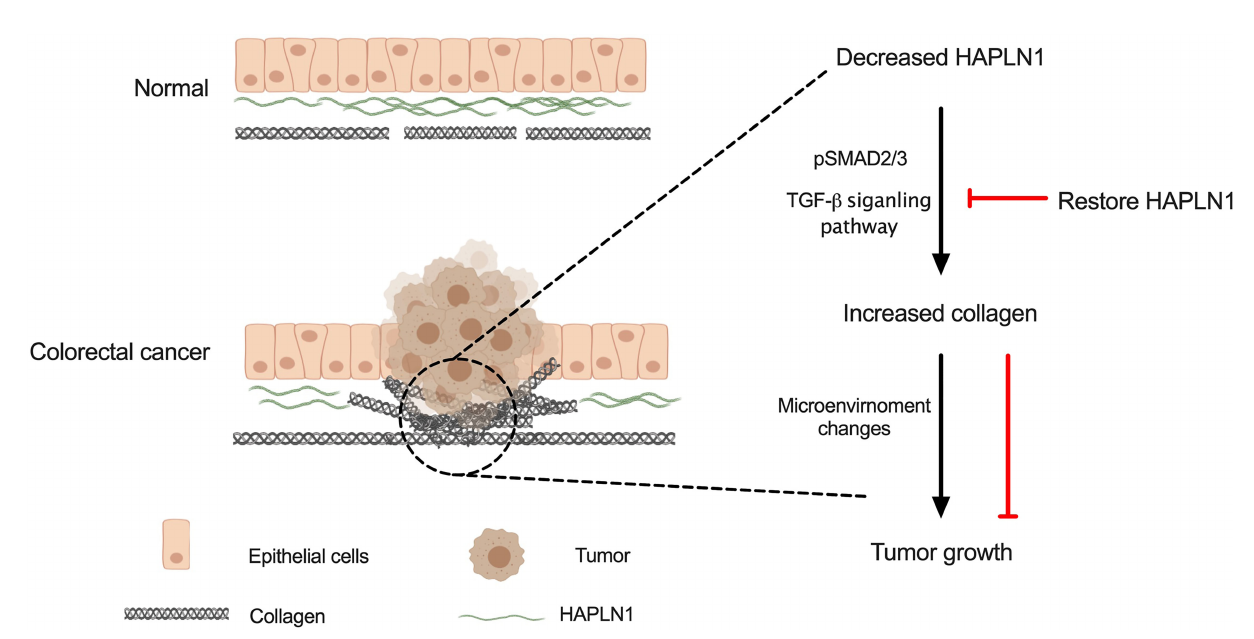
FIGURE 7 | Schematic of HAPLN1 regulation of collagen and tumor growth. Decreased HAPLN1 expression leads to increased collagen deposition via pSmad2/3 in the TGF- b signaling pathway, resulting in tumor growth. Restoring HAPLN1 levels can reduce collagen and inhibit tumor